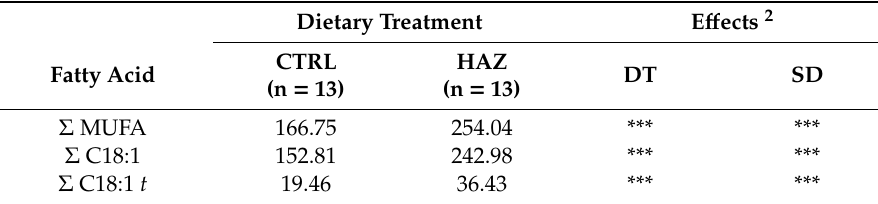
Table 5. Cont. Dietary Treatment E ff ects 2